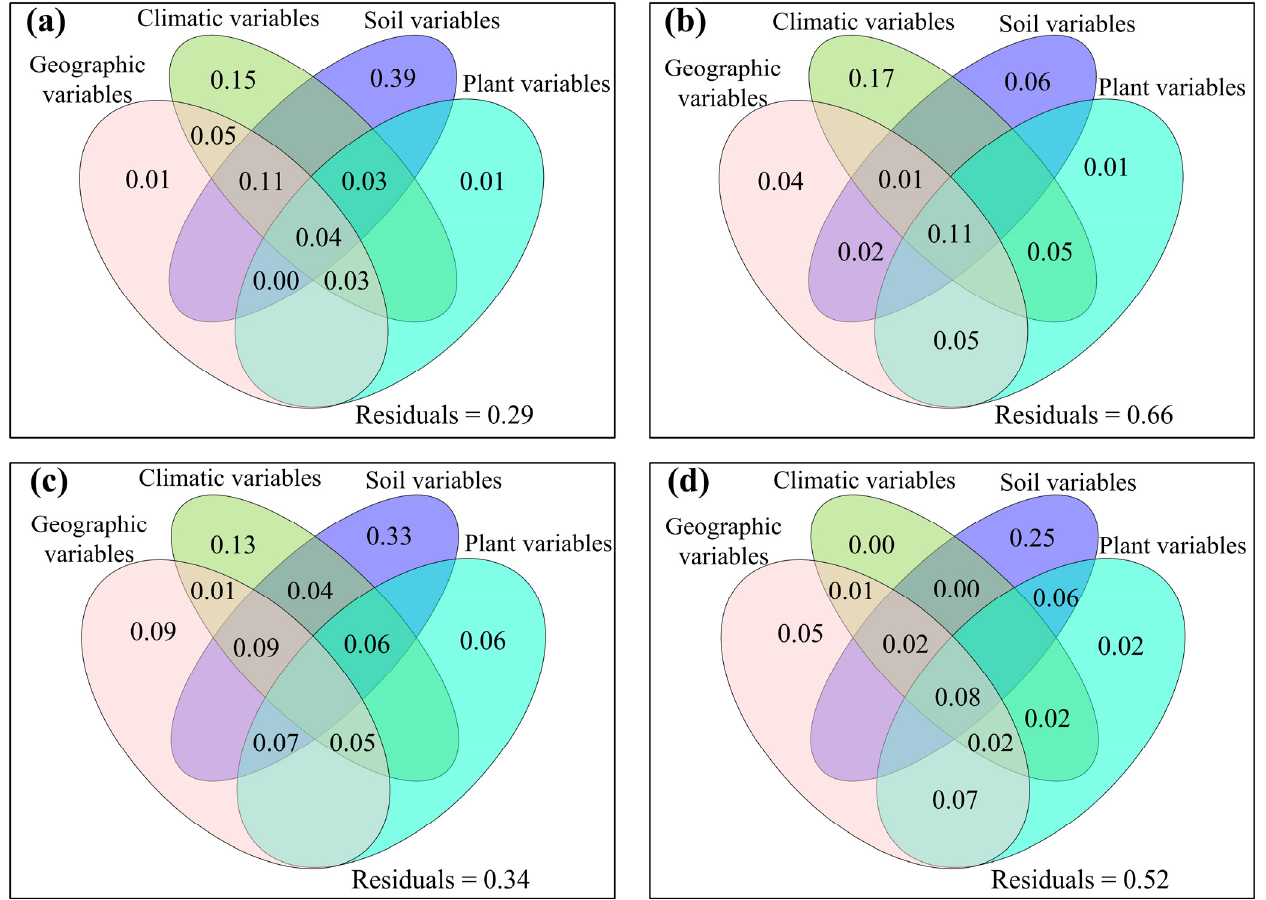
Figure 7. The mutual as well as excluded impacts of geographic variables, climatic variables, soil variables and plant variables on ( a , b ) Faith’s phylogenetic diversity (PD), and ( c , d ) mean nearest taxon distance (MNTD) of soil fungal community for ( a , c ) topsoil and ( b , d ) subtopsoil, respectively.